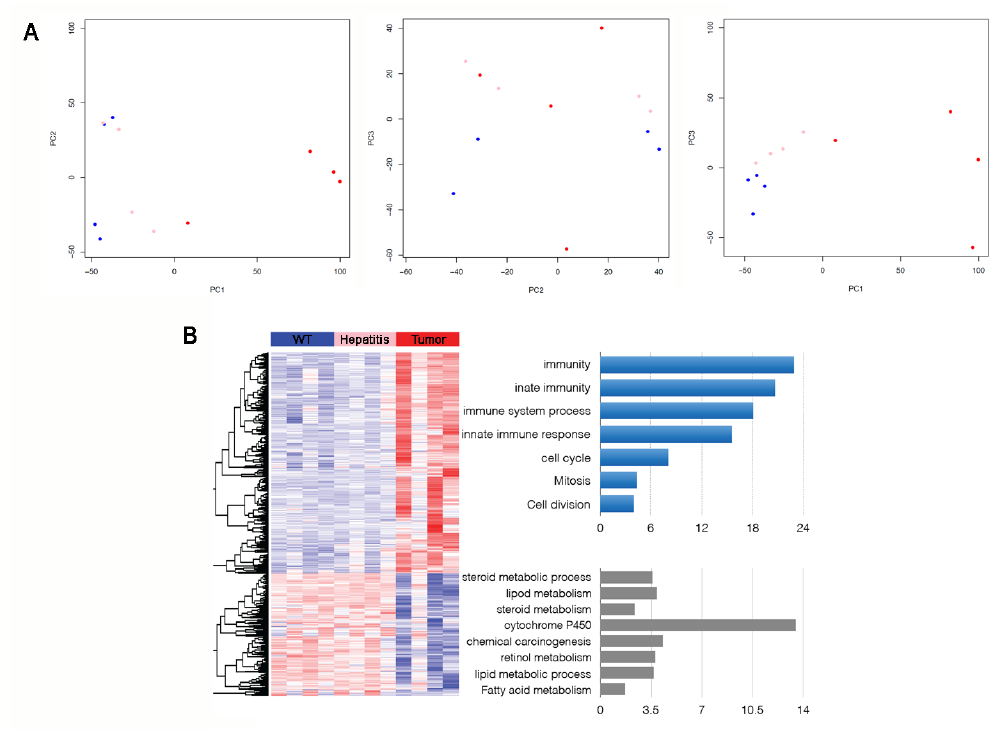
Figure 4. Immune-inflammatory and cell cycle abnormalities in HSV-tk mice tumors. ( A ) Principal components analysis comparing gene expression profiles of HCC, steatotic and WT liver. PC1 is the biggest principal component from the variance. The relationship between the principal component 1 (PC1), PC2, and PC3 (tumor: red dot, Steatotic: pink dot, WT: blue dot); ( B ) Functional analysis of differentially expressed genes of HCC, steatotic and WT liver. Heat map demonstrating down-regulated genes. Immune-inflammatory response and cell cycle-related genes were up-regulated in WT, steatotic and tumor samples. On the contrary, lipid metabolic genes were down-regulated. Red and blue colors indicate high and low gene expression, respectively; the top rank ordered processes are based on statistical